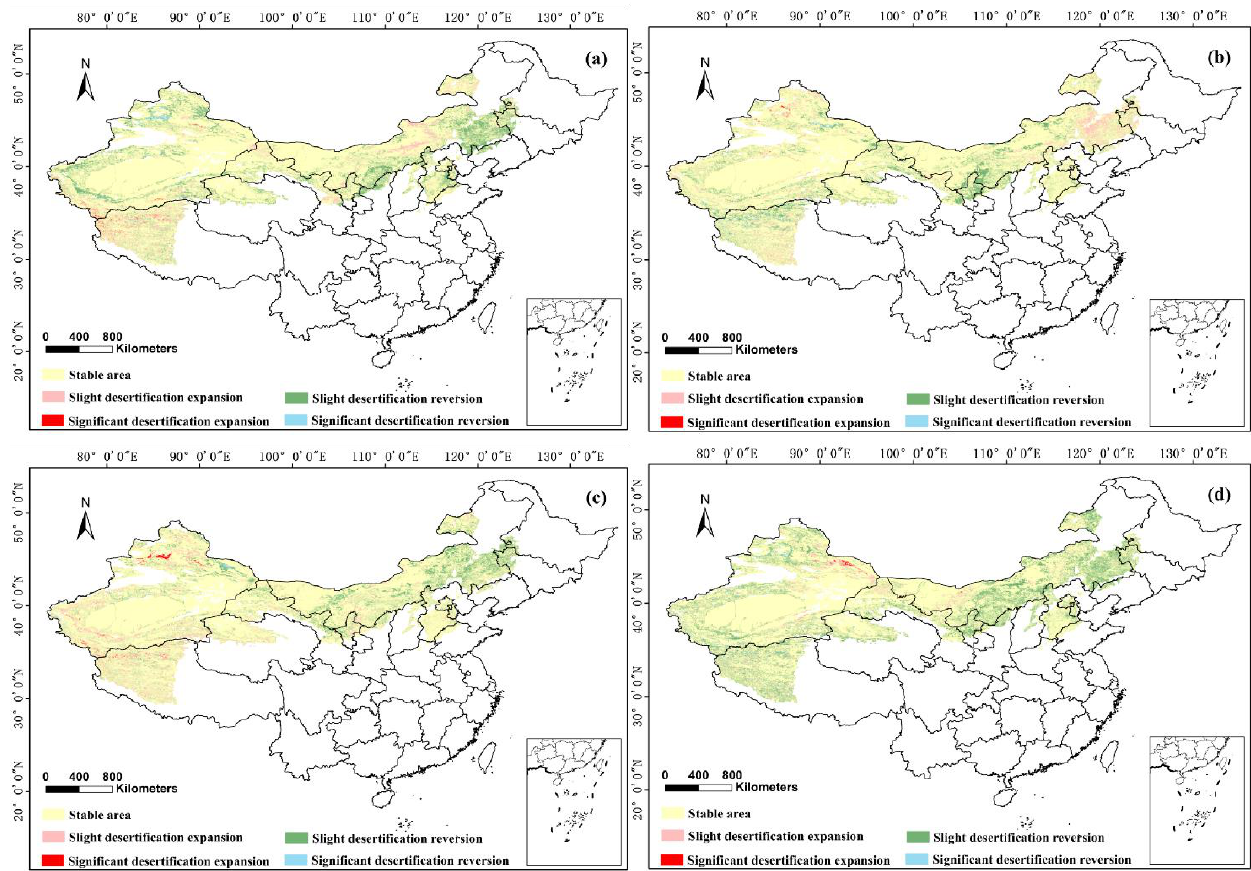
Figure 6. Changes in the degree of desertification from 2000 to 2020. ( a ) 2000 – 2005; ( b ) 2005 –